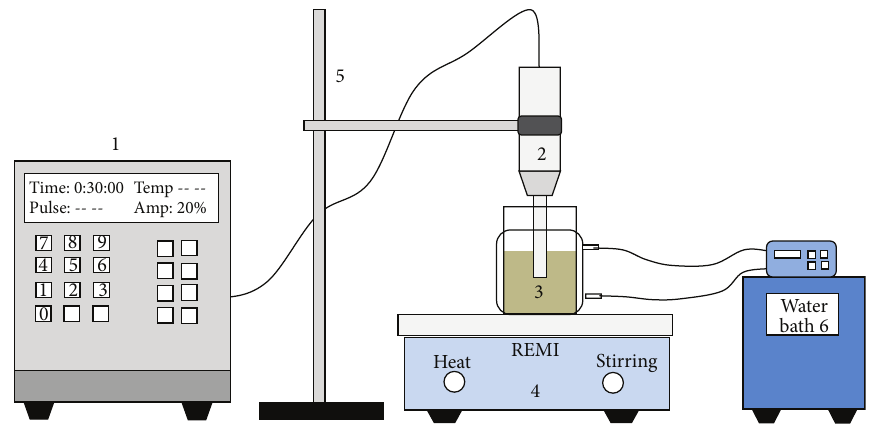
Figure 1: Schematic diagram of experimental setup for sonochemical synthesis of manganese ferrite. (1) Sonic processor, (2) transducer, (3) reaction mixture, (4) magnetic stirrer with hot plate, (5) stand, and (6) water cooler.